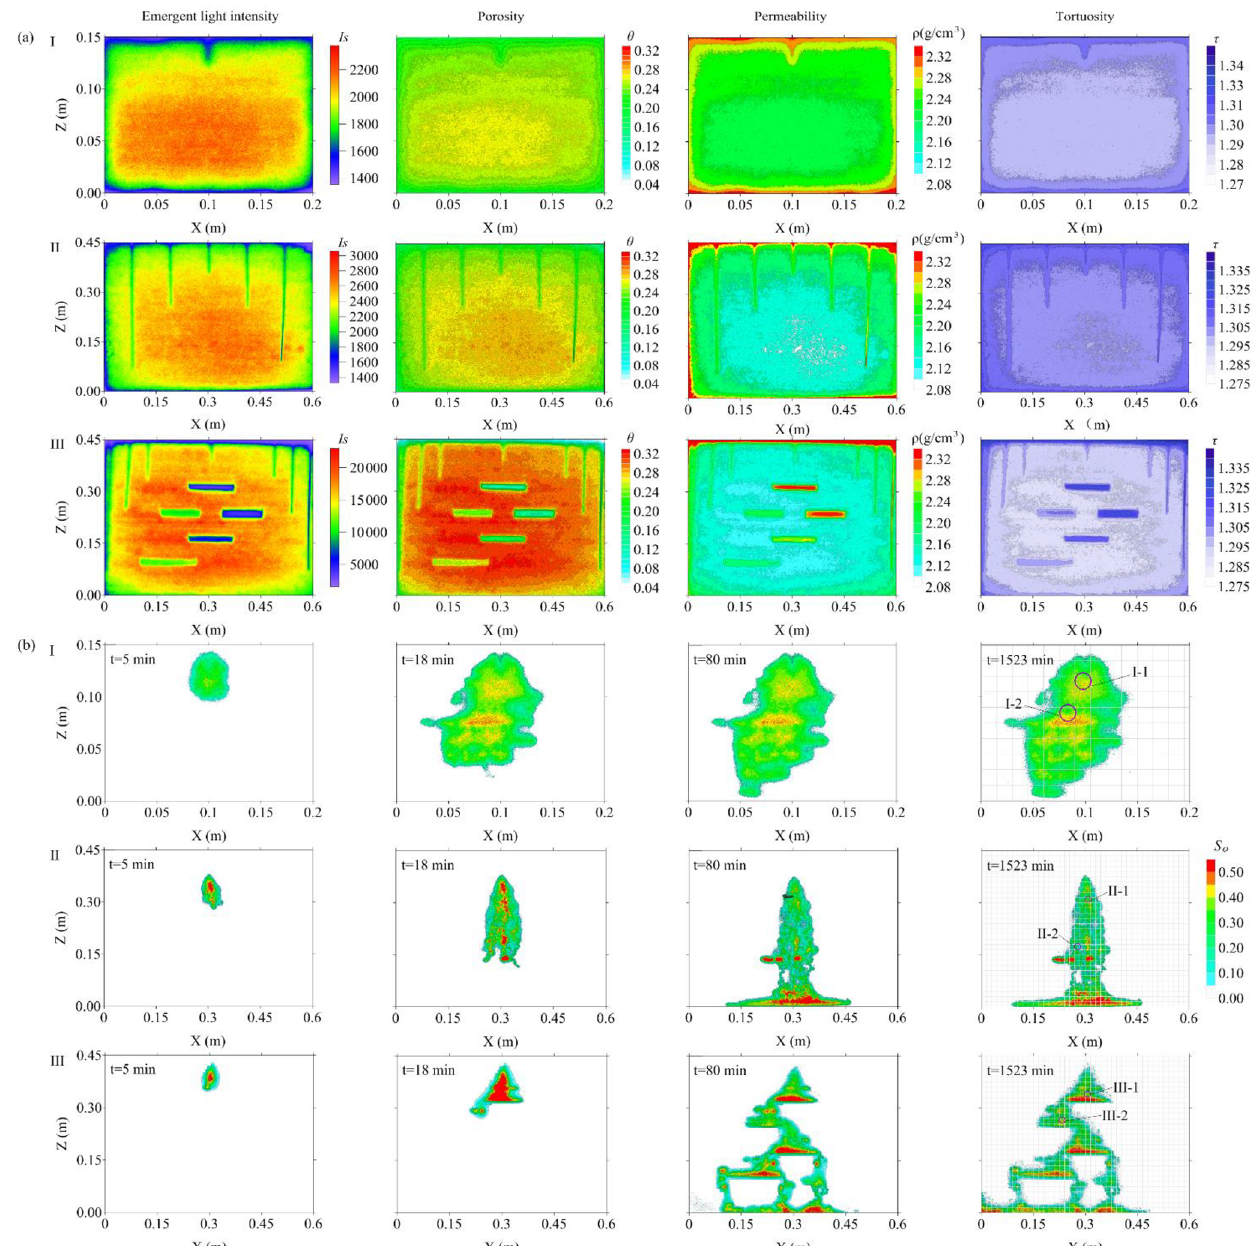
Figure 3. (a) The emergent light intensity, porosity, permeability, and tortuosity of 2D translucent silica sand for Experiments I–III; (b) the PCE saturation of Experiments I–III during 0–1523min and observation